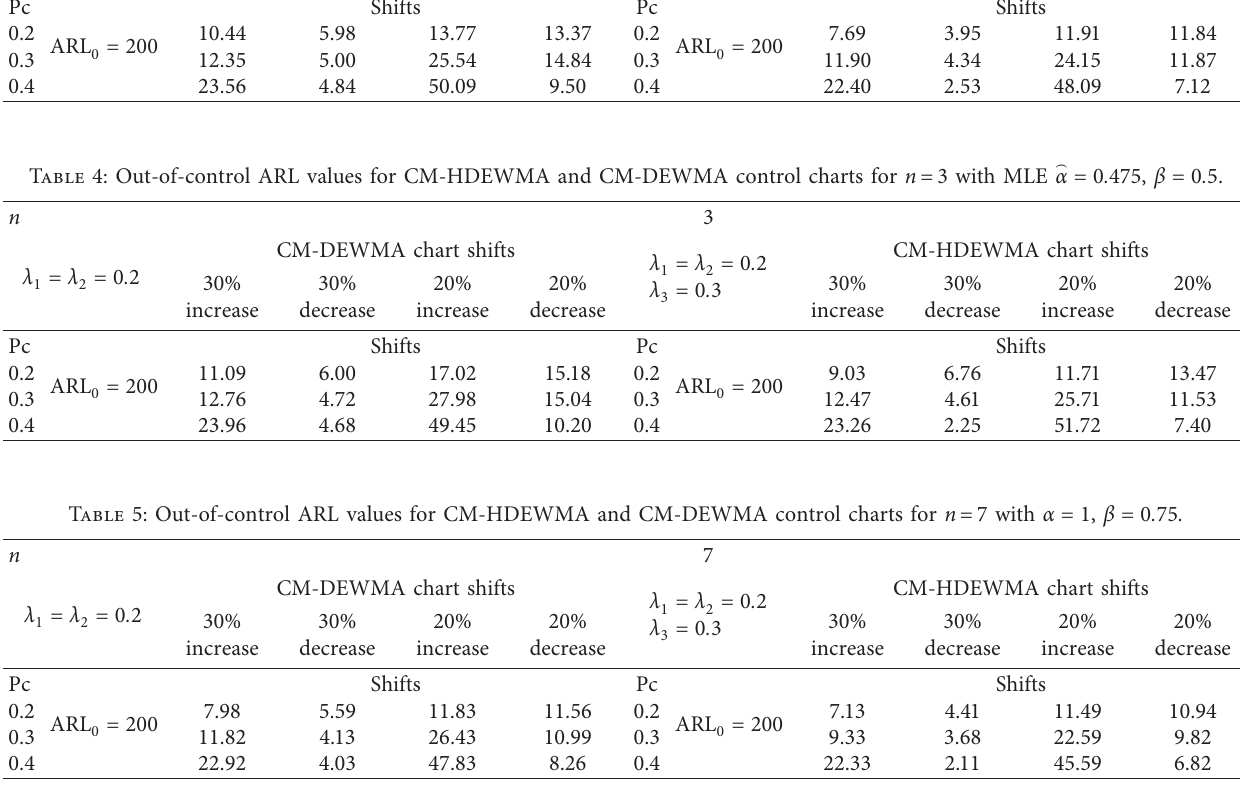
Table 3: Out-of-control ARL values for CM-HDEWMA and CM-DEWMA control charts for n � 3 and α � 0 . 5 , β � 0 . 5. n 3 � λ � 0 . λ 1 2